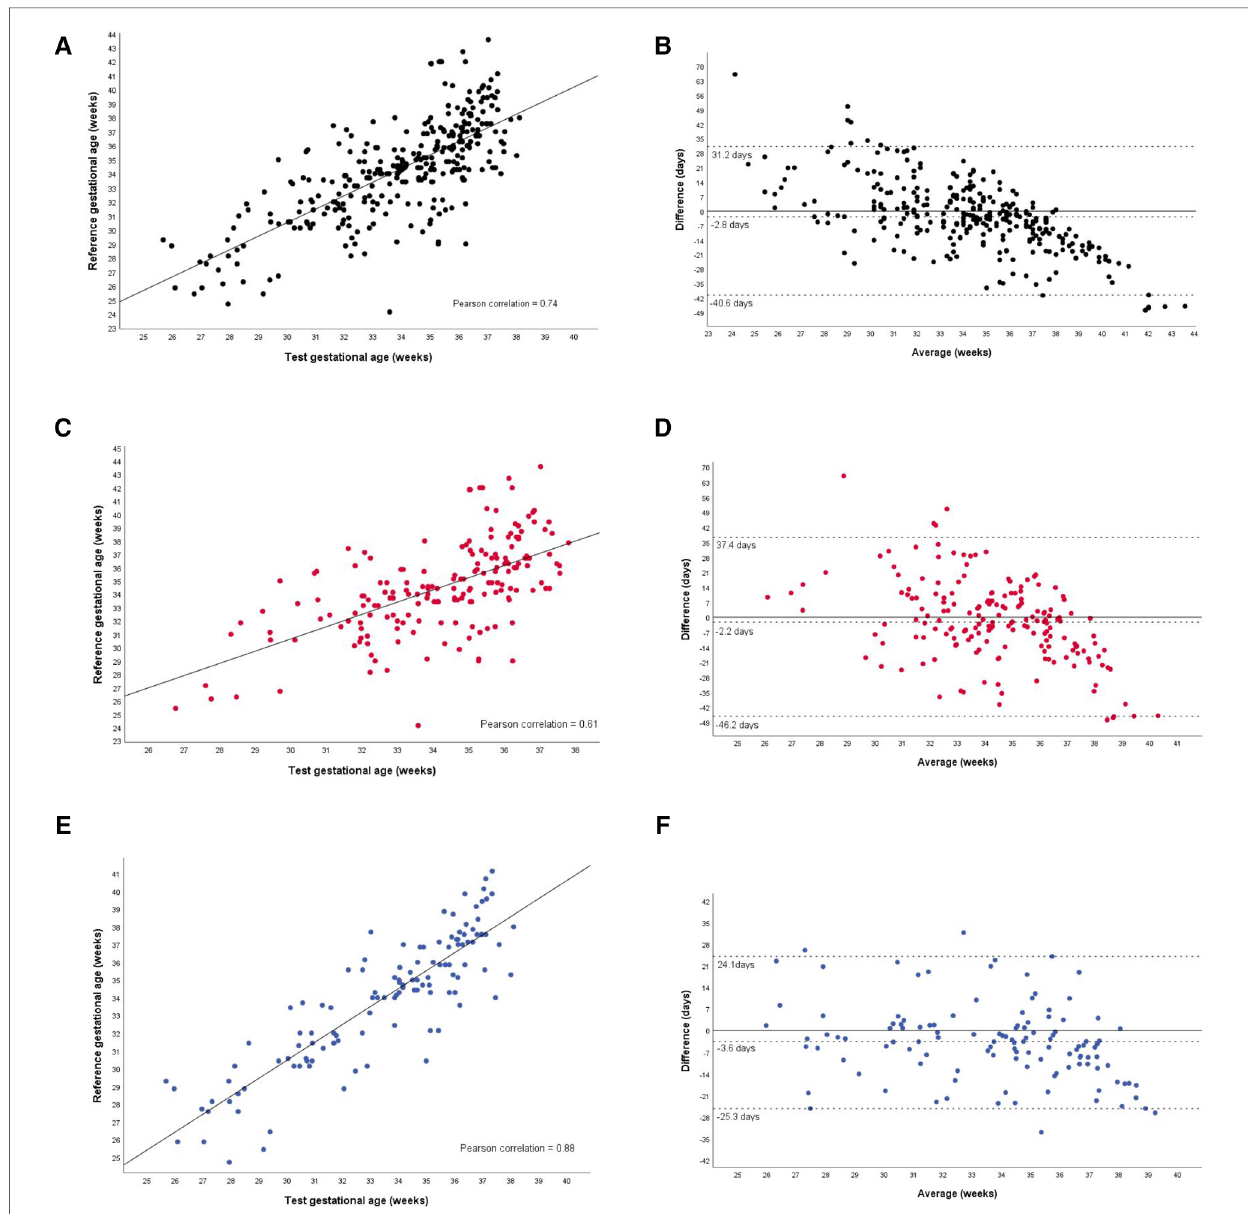
FIGURE 4 Agreement between the gestational age test and the reference gestational age, in the total group and subgroups. Total group ( A,B ). Gestational age based on the last menstrual period ( C,D ). Gestational age based on prenatal ultrasound before 24 weeks of gestation ( E,F